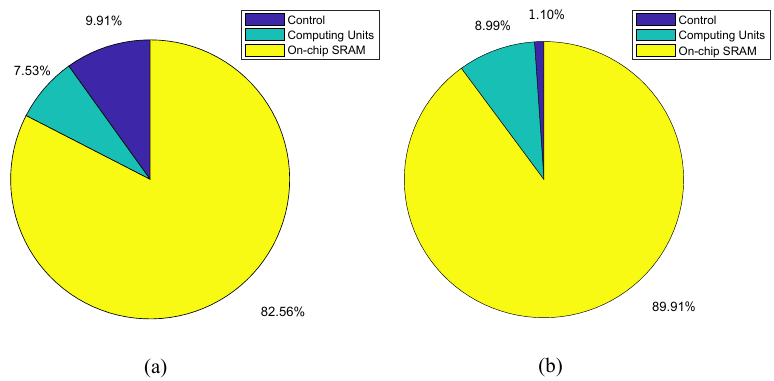
Figure 13. Synthesis Results of the Breakdown: ( a ) area, ( b )